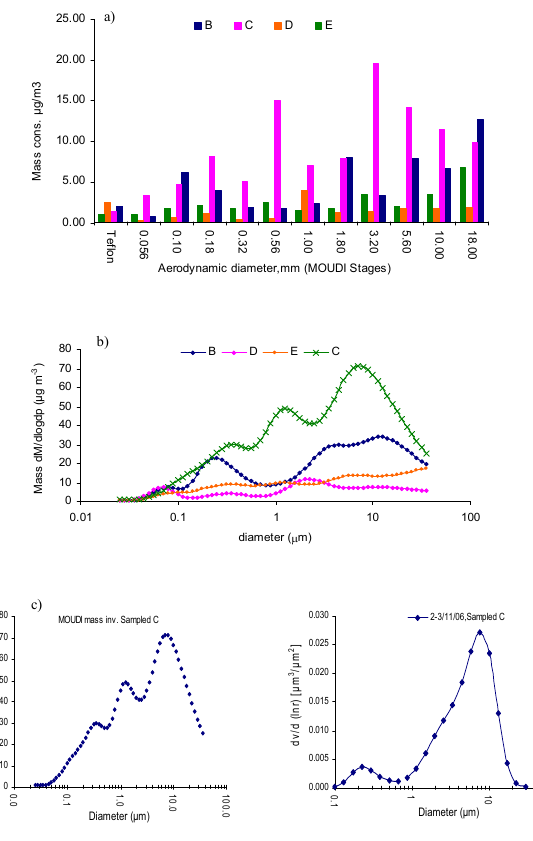
Fig. 7. (a) Size resolved mass concentrations for all 4 samples. (b) Smoothed size distributions. (c) Comparison of MOUDI size distribution with AERONET retrieval for sample C.